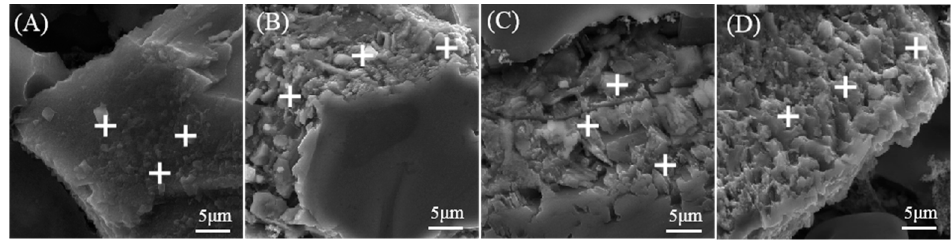
Figure 6. SEM image of SiCp/7085 composites interface products under different ultrasonic treatment time: ( A ) 0 min; ( B ) 5 min; ( C ) 10 min; ( D ) 15 min;.